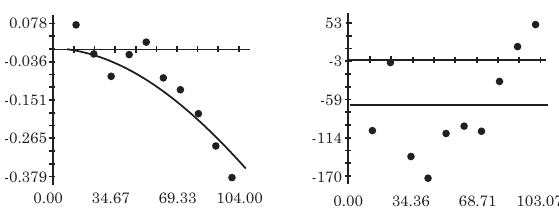
Figura 4. Semivariogramas cruzados dos atributos estudados. Gaus: gaussiano; Esf.: esférico; Co: efeito pepita; C1: patamar; a: alcance, em m; e R 2 : coeficiente de